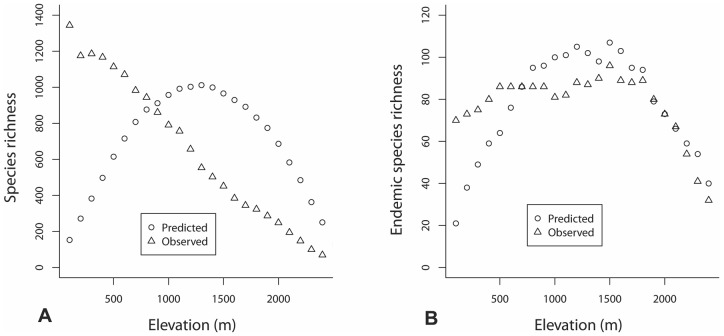
Predicted of the null model simulation and observed values of species richness concerning mid-domain effect.The comparisons concern to (A) vascular plant species richness and (B) Single Island Endemics.